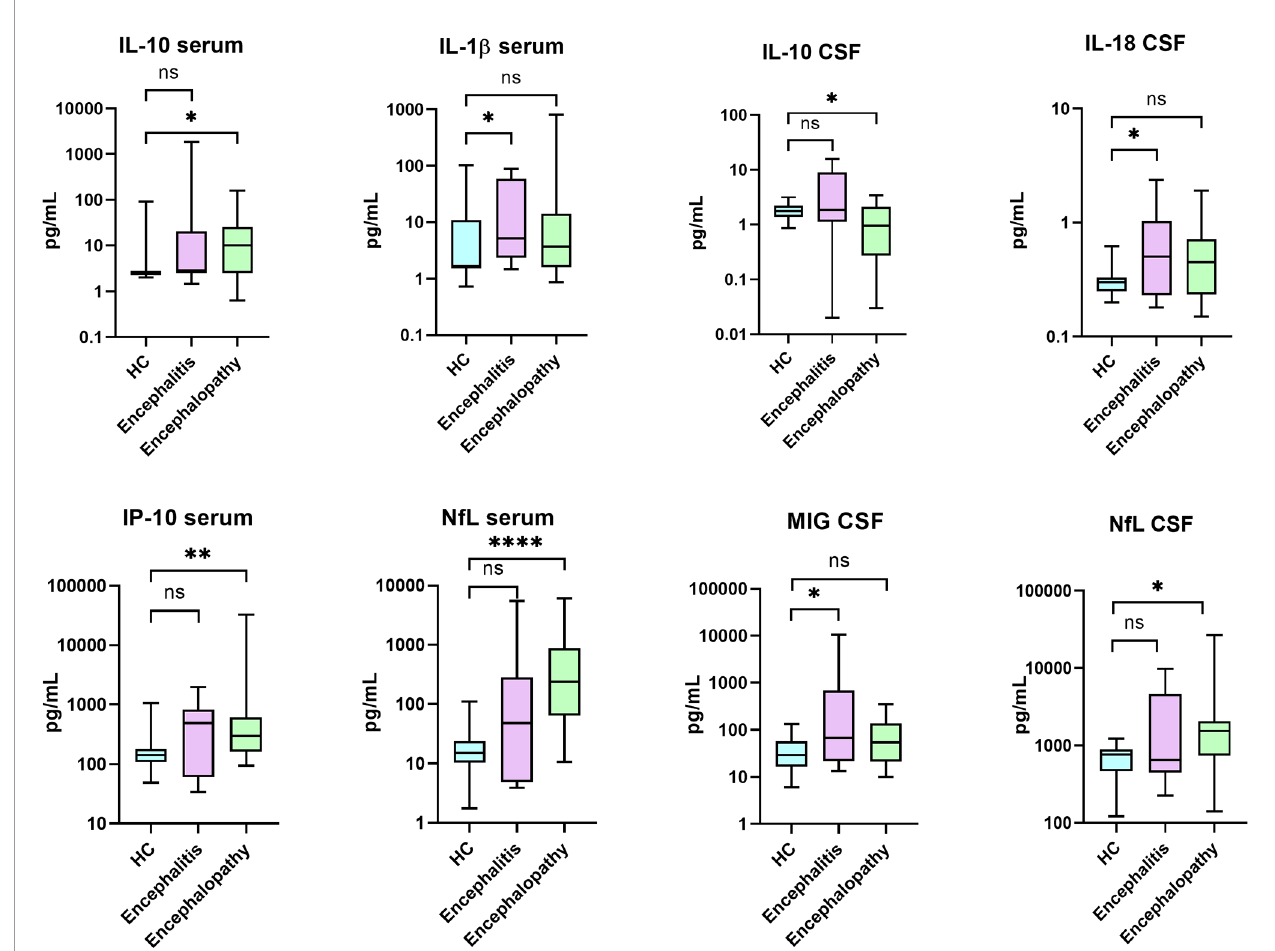
FIGURE 2 | Levels of biomarkers that were found signi fi cantly different when comparing patients with COVID-19 associated encephalitis and encephalopathy with healthy controls (HC). Comparative analyses were performed using Mann-Whitney U test. IL, interleukin; IP, IFN- g – induced protein; NfL, Neuro fi laments; MIG, monokine induced by interferon (IFN)-gamma. (*) p<0.05; (**) p<0.01; (****) p<0.0001; ns, not signi fi